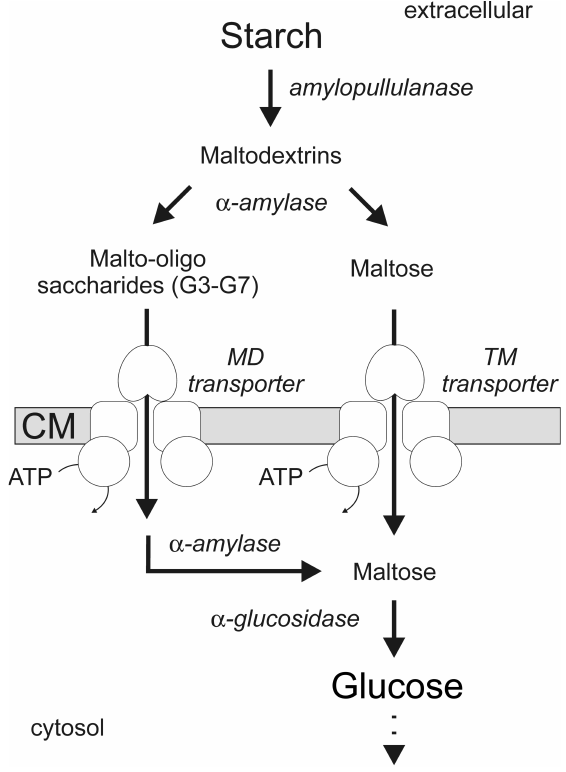
Figure8. Schemeof α -glucosidemetabolismin Pyrococcusfuriosus